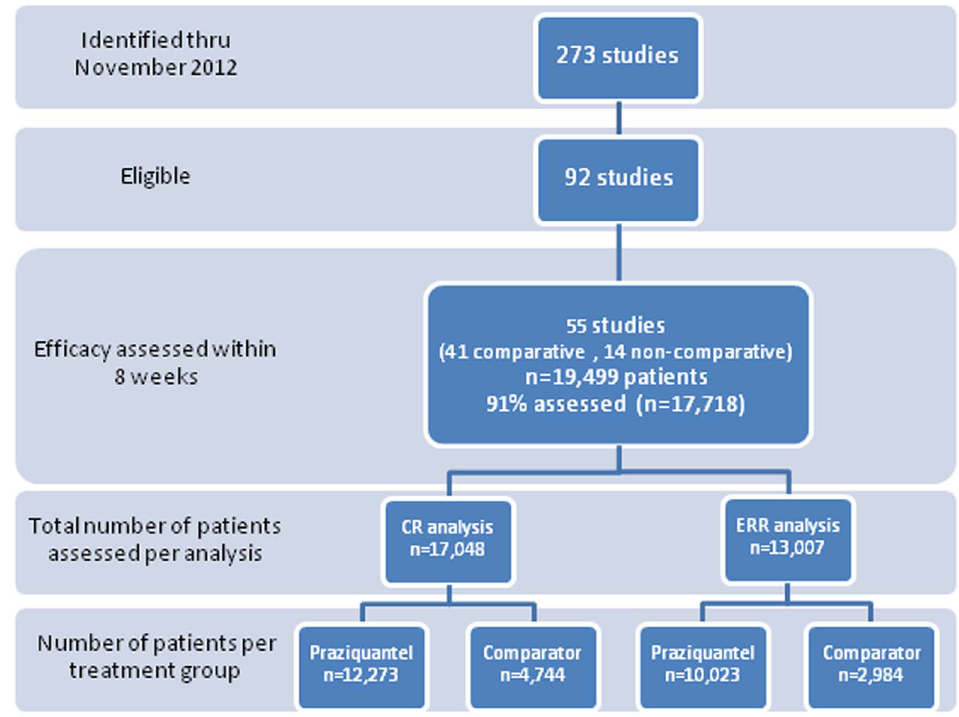
Figure 1. Flow chart of the number of studies and patients screened and eligible for the efficacy analyses of cure rate (CR) and egg reduction rates (ERR). Of the 41 comparative studies identified, 19 directly compared different doses and schedules of PZQ; 7 compared praziquantel with artesunate combined with praziquantel, sulfalene, sulfamethoxypyrazine/pyrimethamine, or mefloquine; 6 with artesunate alone; 3 with metrifonate; 1 with nitrifonate and 1 with metrifonate + nitrifonate; 6 with oxamniquine, 4 with oltipraz, 1 with albendazole, 1 with mefloquine, and 3 with PZQ in combination with artemether, albendazole, or metrifonate.